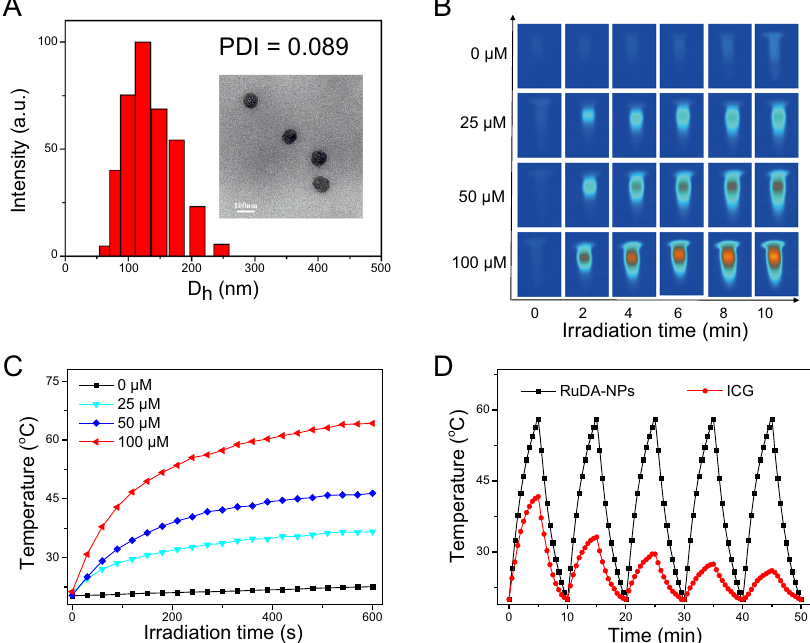
Fig. 5 The characterization and photothermal properties of RuDA-NPs. A DLS analysis and TEM image (inset) of RuDA-NPs. B Thermal images of RuDA- NPs at different concentrations under 808 nm (0.5 W cm -2 ) laser irradiation. C Photothermal conversion pro fi le of RuDA-NPs at different concentrations, which is the quantitative data of B . D Temperature elevation of RuDA-NPs and ICG during fi ve cycles of heating-cooling